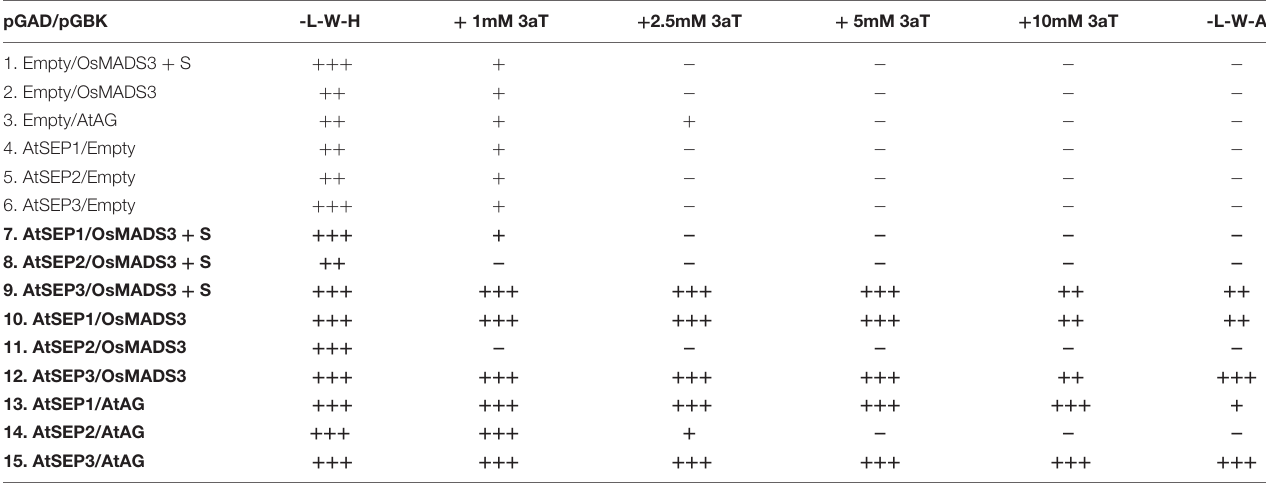
TABLE 2 | Summary of yeast-2-hybrid